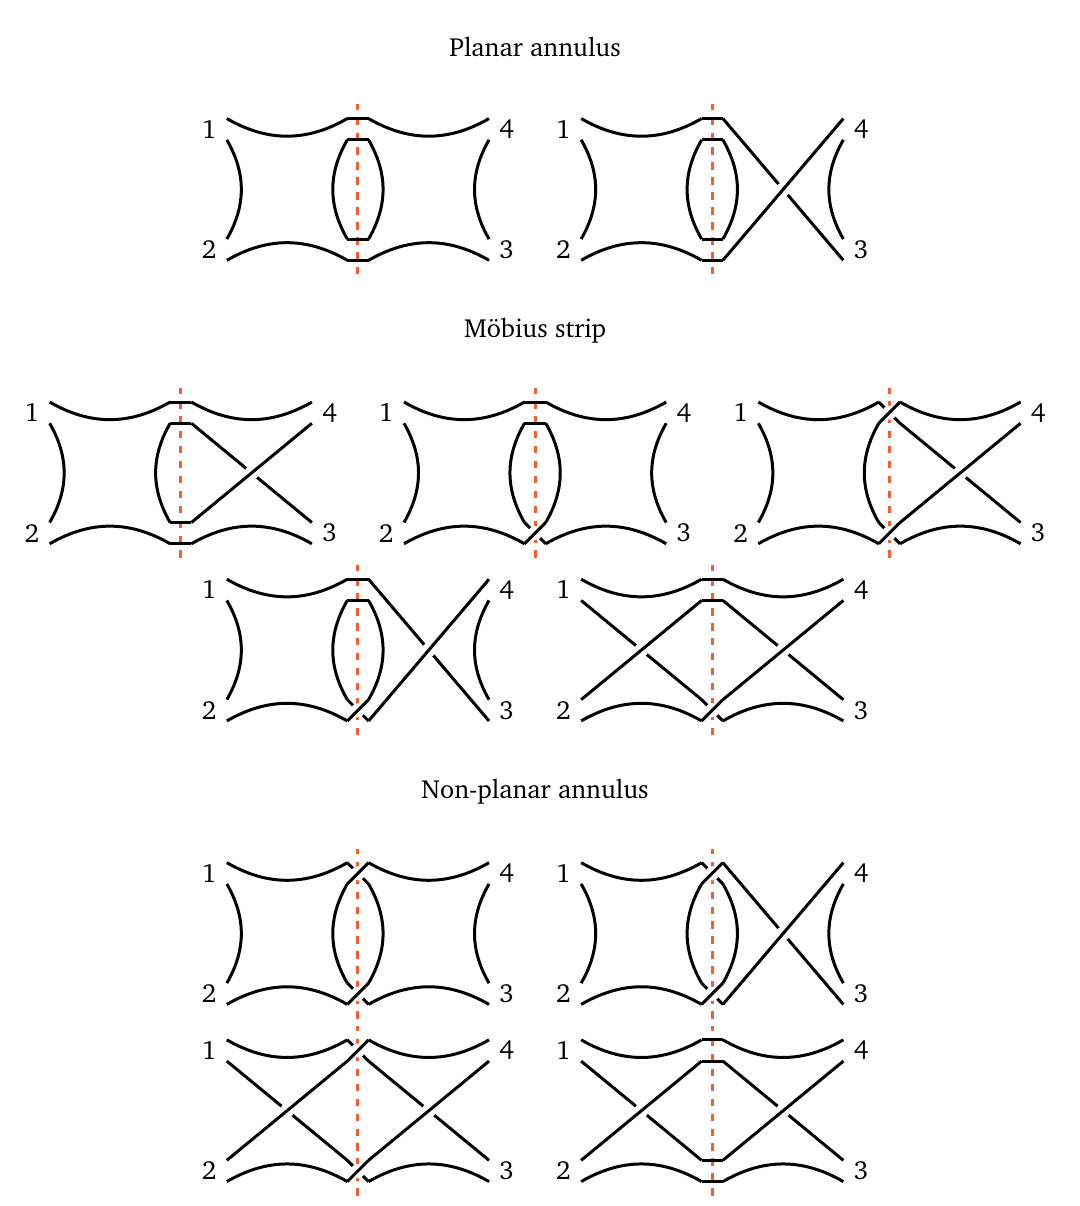
Figure 9: Different possibilities for the color contractions of two tree-level four- point functions in the s -channel, corresponding to the terms in the planar annulus (3.13), Möbius strip (3.14), and non-planar annulus (3.15) contributions, before using symmetry